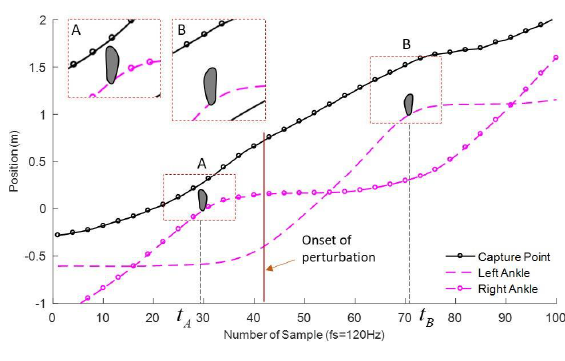
Figure 2. Relationship of CP and the swing foot in different walking speed.